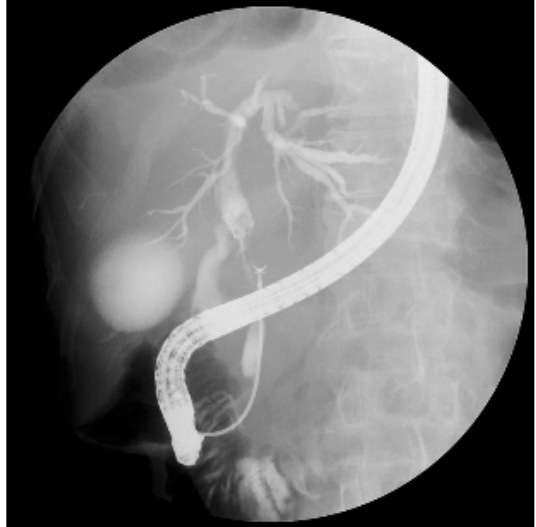
Figure 2. Fluoroscopic image of a fluoroscopy-guided biopsy in a case of suspected bile duct cancer.